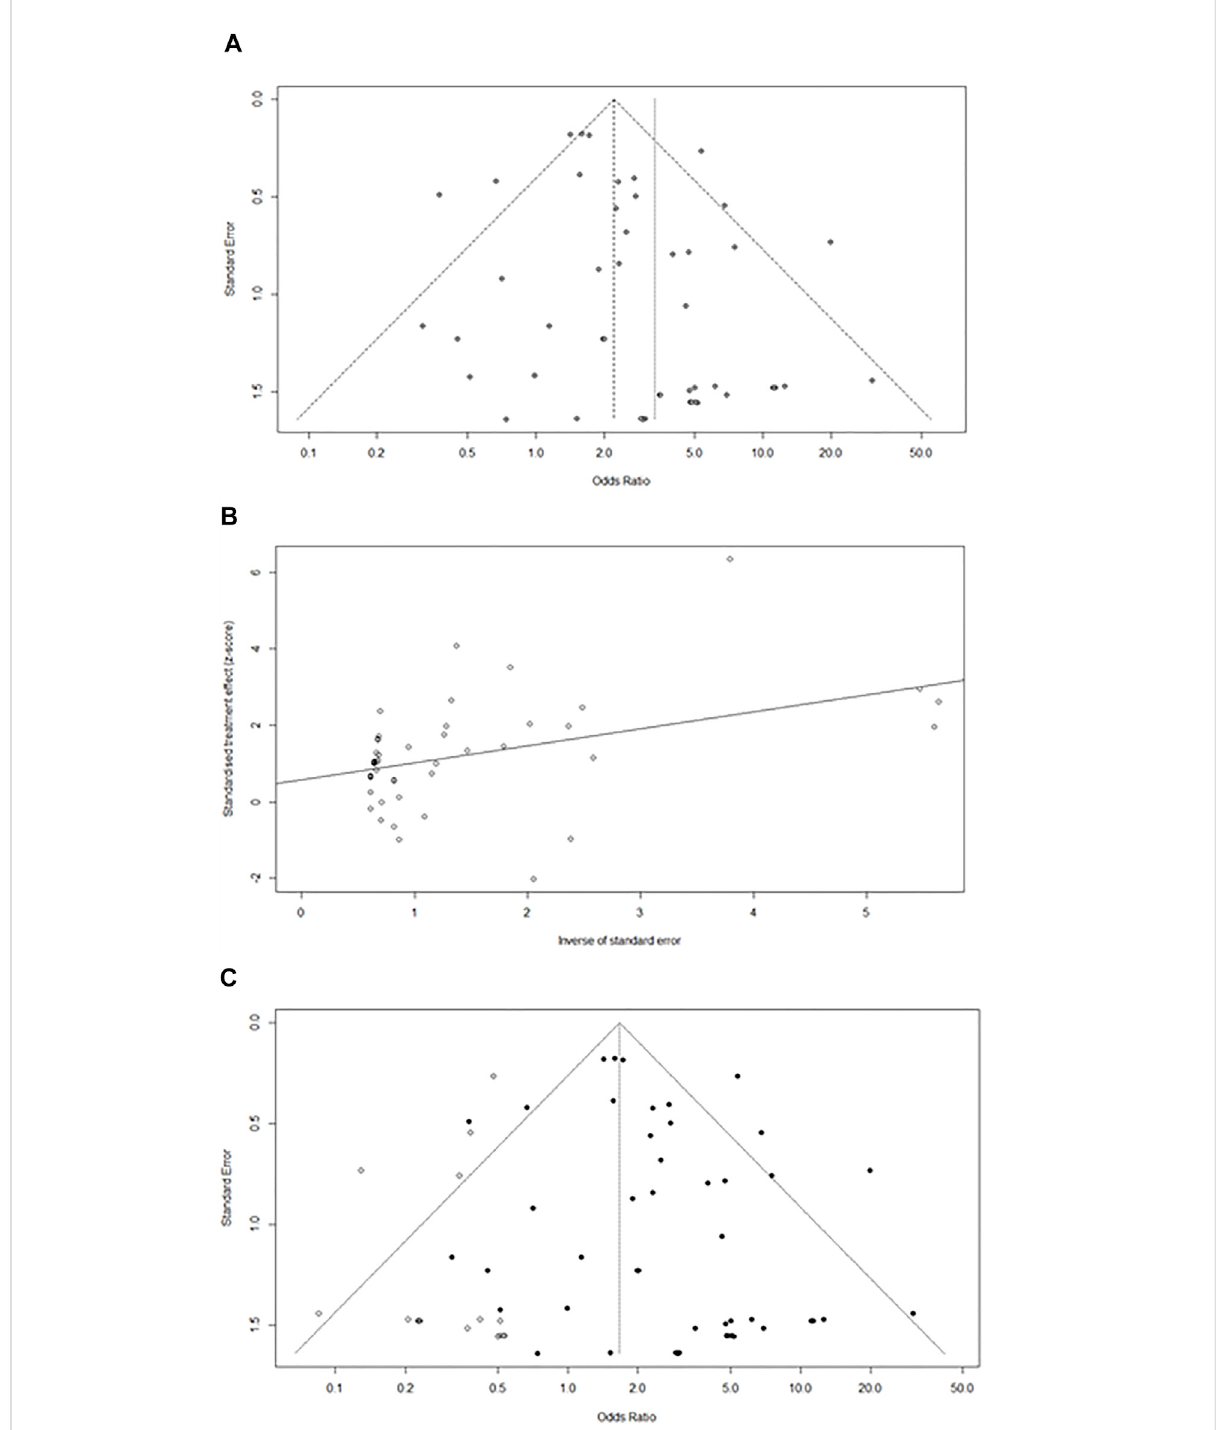
FIGURE 3 (A) Funnel plot of pancreatic injury caused by ICIs. (B) Egger test linear analysis plot. (C) Publication bias funnel plot after trim-and- fi